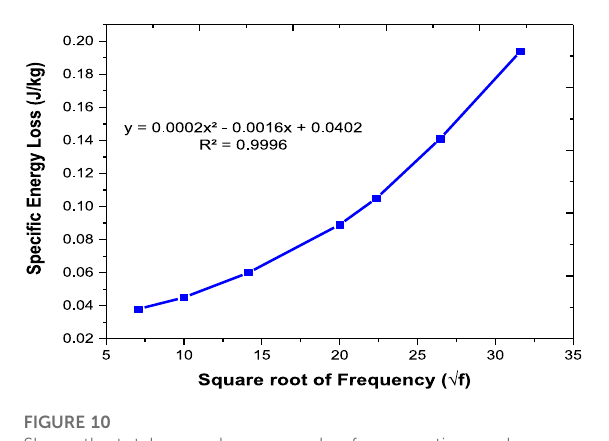
FIGURE 10 Shows the total power loss per cycle of a magnetic sample made of NO steel at a 1.5 T fl ux density against the square root of